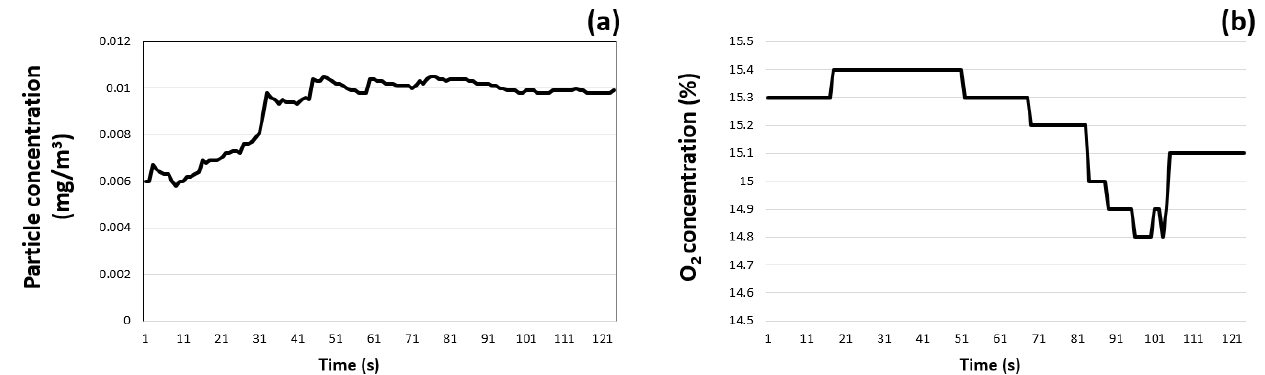
Figure 13. Graph showing ( a ) particle concentration and ( b ) O 2 concentration in underground mine.